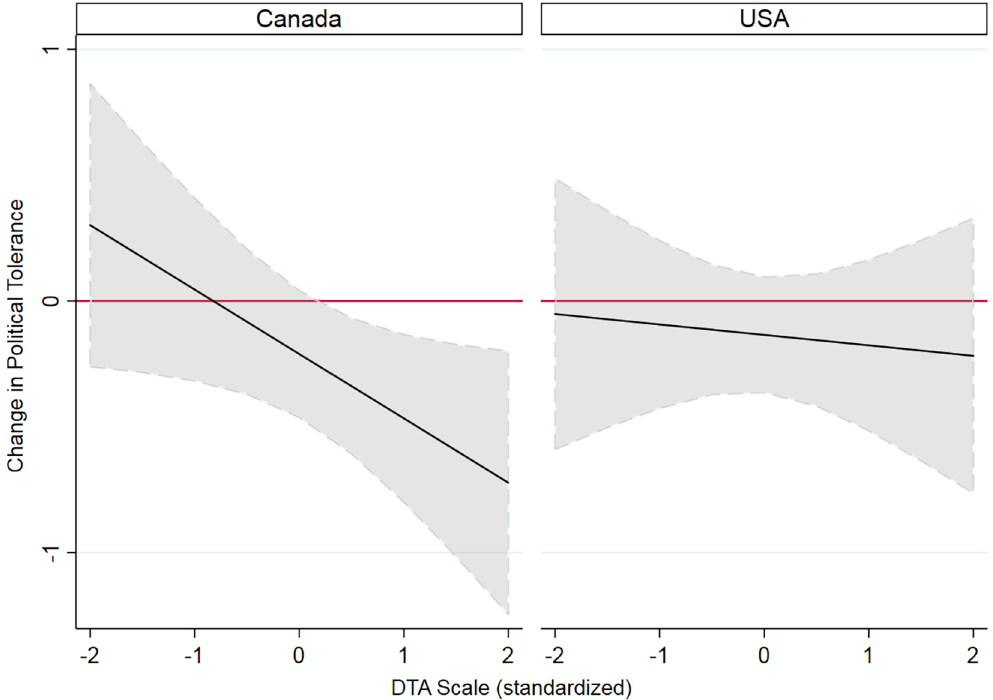
Figure 2. Average marginal effects of authoritarianism on political tolerance by level of death thought accessibility (DTA): Canada and